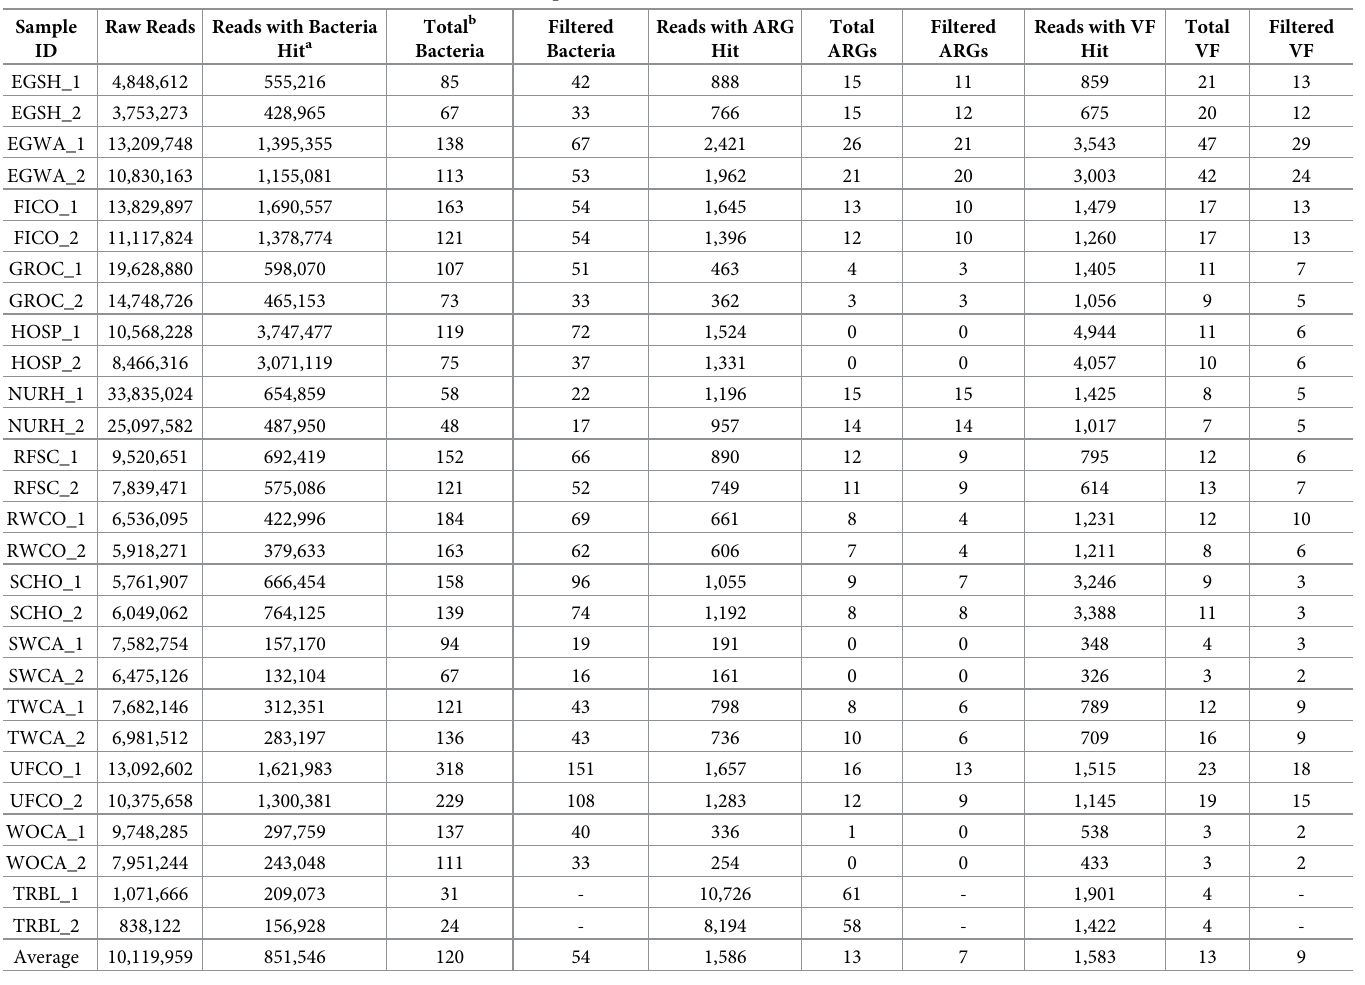
Table 1. Raw reads, unfiltered reads, and filtered hits for each